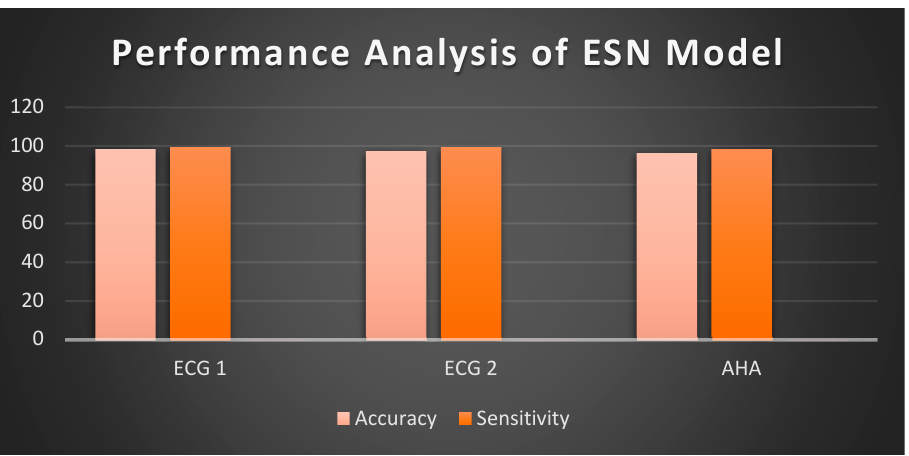
Figure 11. Graphical representation of the performance Analysis of the ESN model.